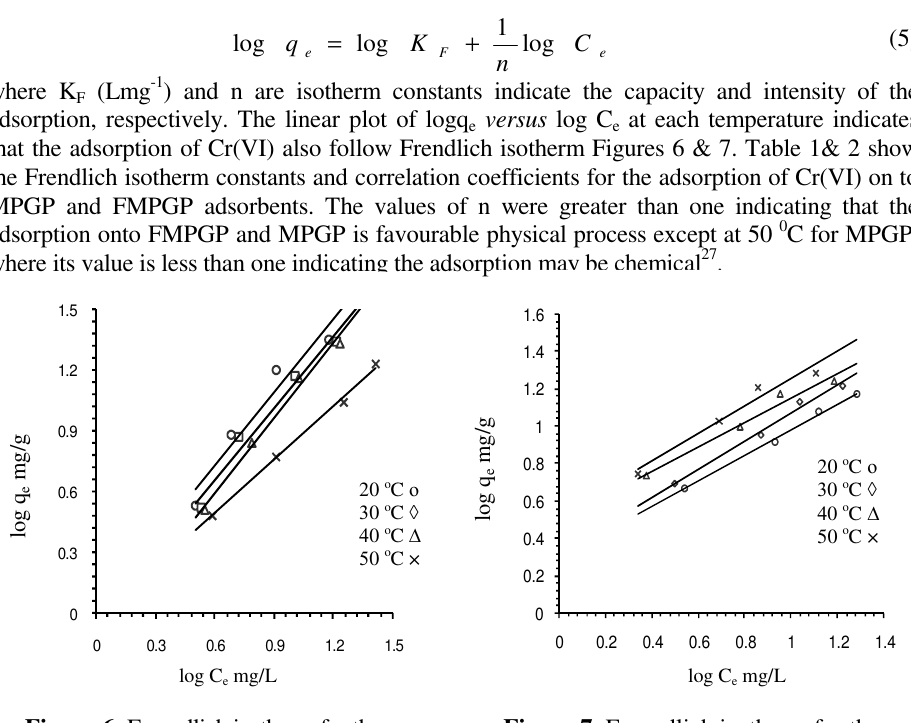
Figure 7. Freundlich isotherm for the adsorption of Cr(VI) onto FMPGP at different